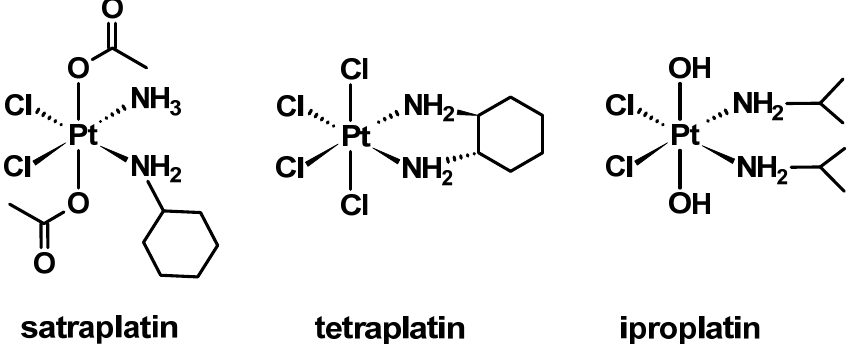
Figure 3. Platinum(IV) complexes that were clinically investigated but failed clinical trials.